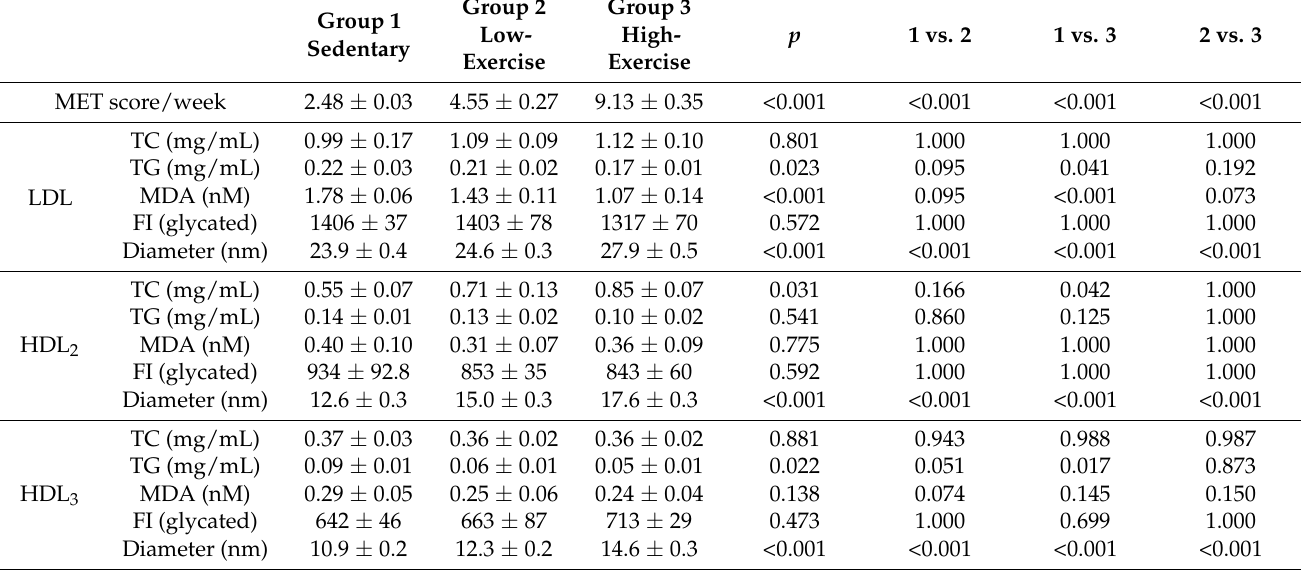
Table 3. Lipid compositions, oxidation extent, and glycation extent of lipoproteins from